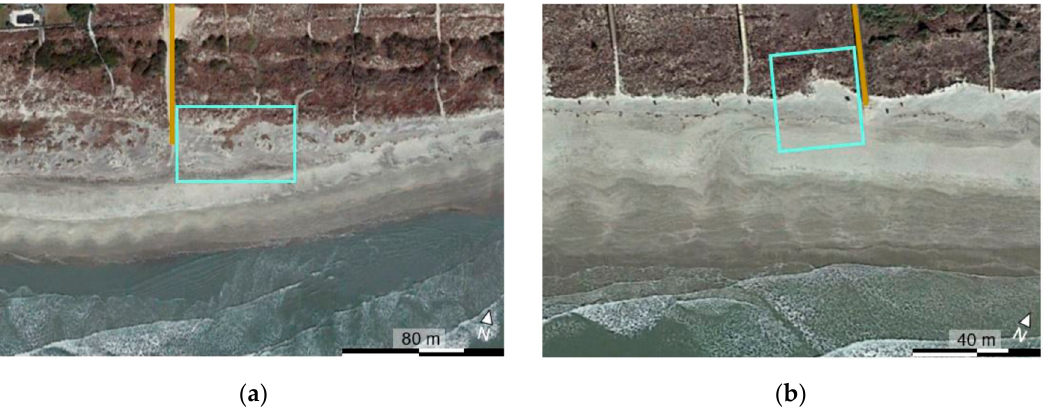
Figure 2. Aerial images of ( a ) Sites A and ( b ) B. The yellow colored lines show the location of the pedestrian boardwalk at ( a ) and the 53rd Avenue beach access ( b ). Google Earth imagery from March 2018.